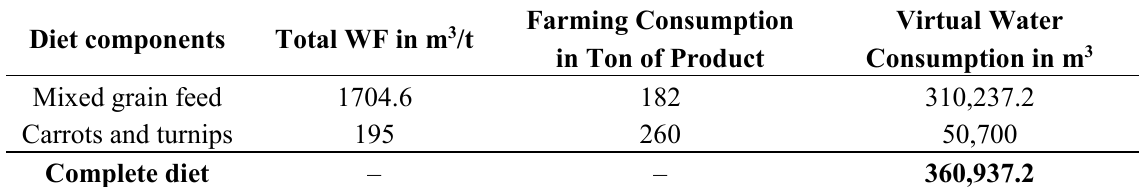
Table 3. Annual virtual water consumption of the farmed insect diet.